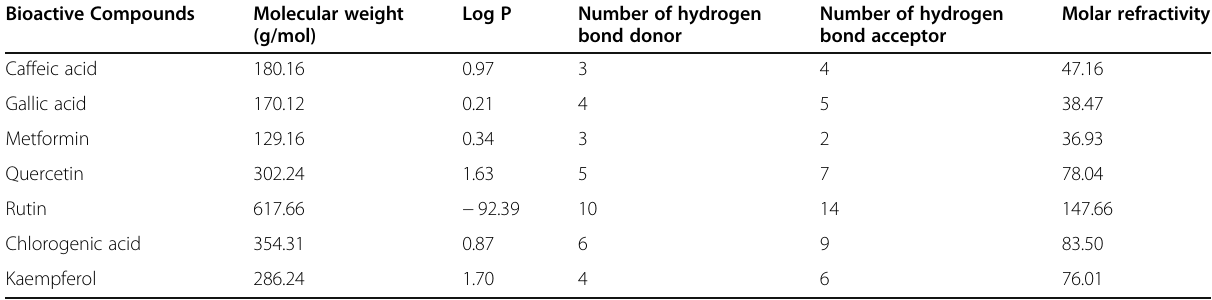
Table 2 Analysis of oral drug-likeness of the six bioactive compounds using Lipinski ’ s rule of five Bioactive